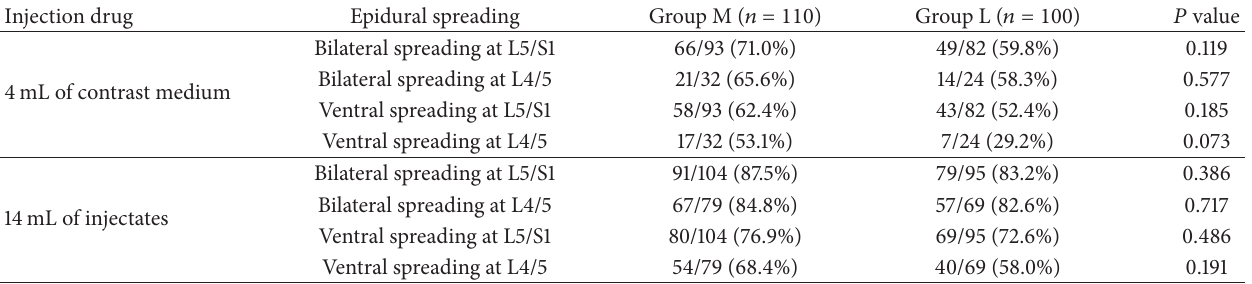
Table 3: The rates of bilateral and ventral epidural spread in groups M and L after injection of 4mL of contrast medium or 14 mL of injectates. Injection drug